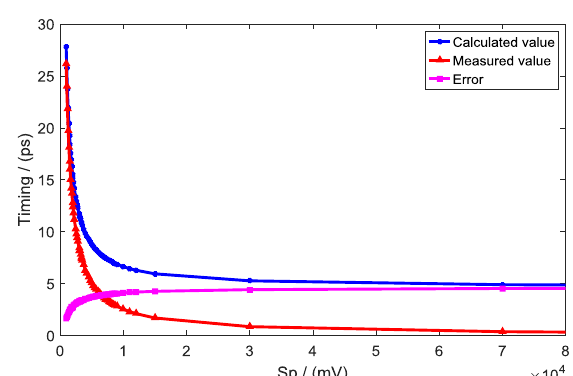
Figure 6. Accuracy evaluation of timing point for fitting